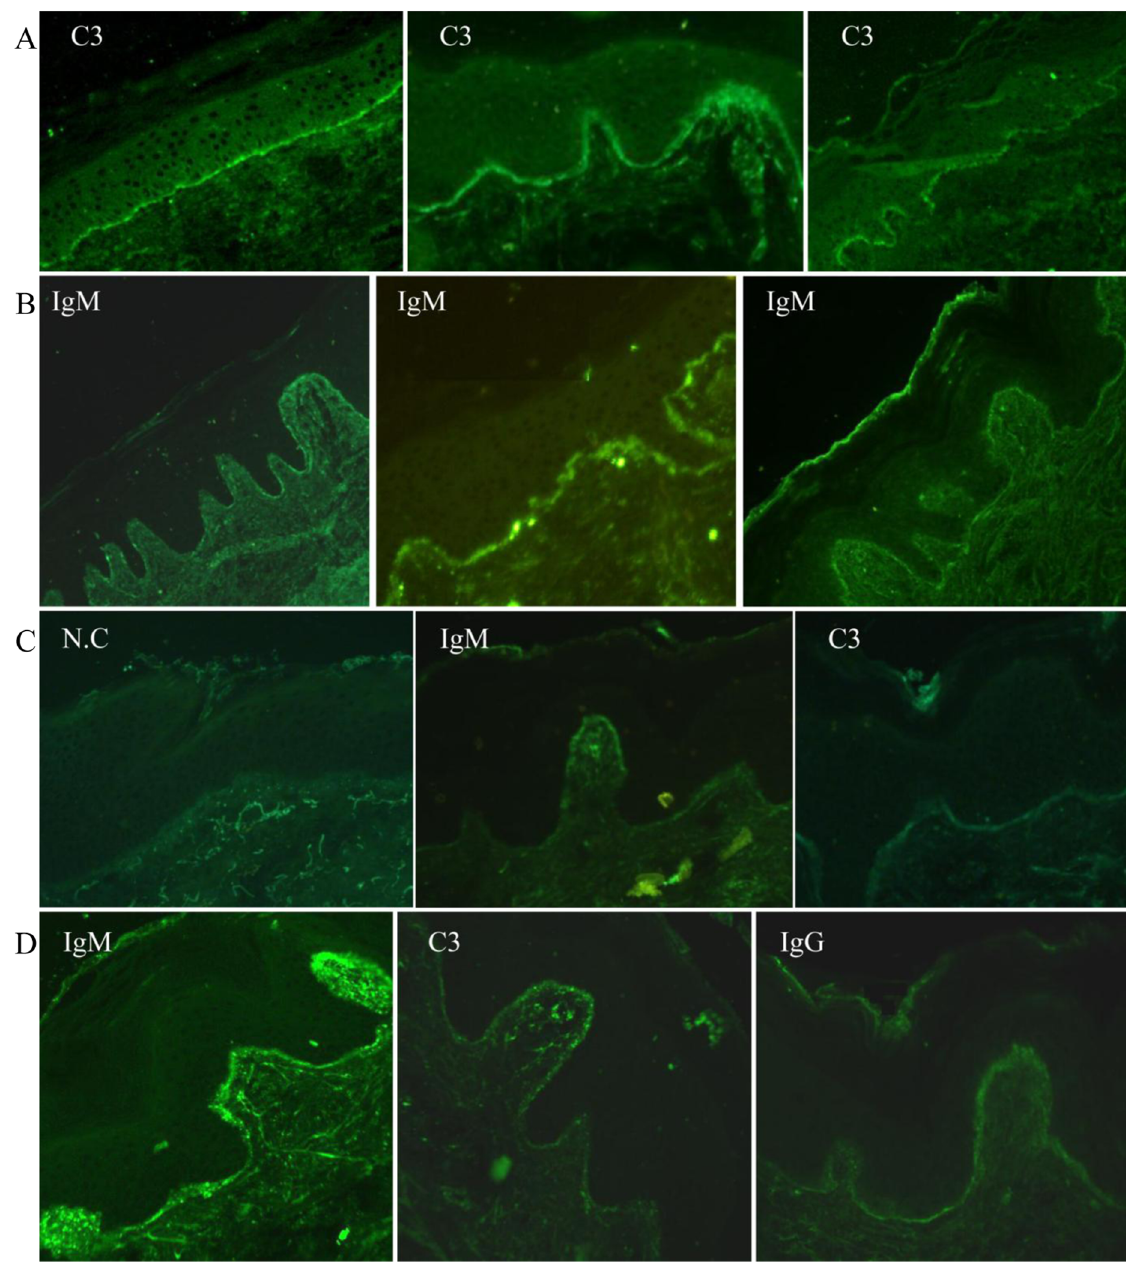
Figure 2. Deposit of immunoreactants along epidermal-dermal junction in lesional skin. Skin sections were incubated with fluorescein isothiocyanate (FITC)-conjugated anti-human IgG, IgA, IgM, and C3 antibodies and visualized with a fluorescence microscope. A and B indicates the staining patterns of single immunoreactant detected from individual biopsy. The representative staining of the coexistence of two and three immunoreactants from two biopsies were shown in C and D, respectively. N.C, negative control without adding FITC-conjugated antibody.